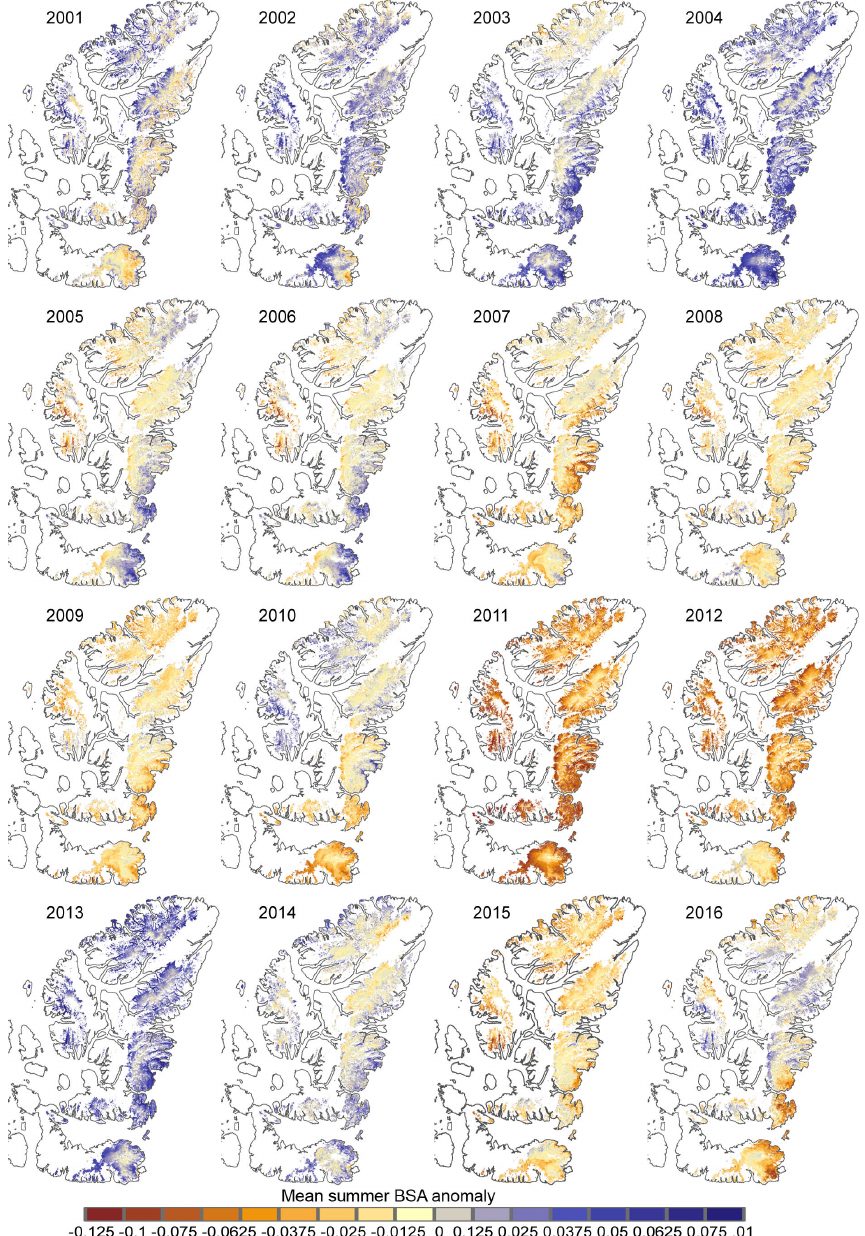
Figure 3. Mean summer clear-sky shortwave broadband albedo anomaly over the QEI ice caps relative to the 2001–2016 mean. White areas outside of the ice caps indicate non-glaciated land